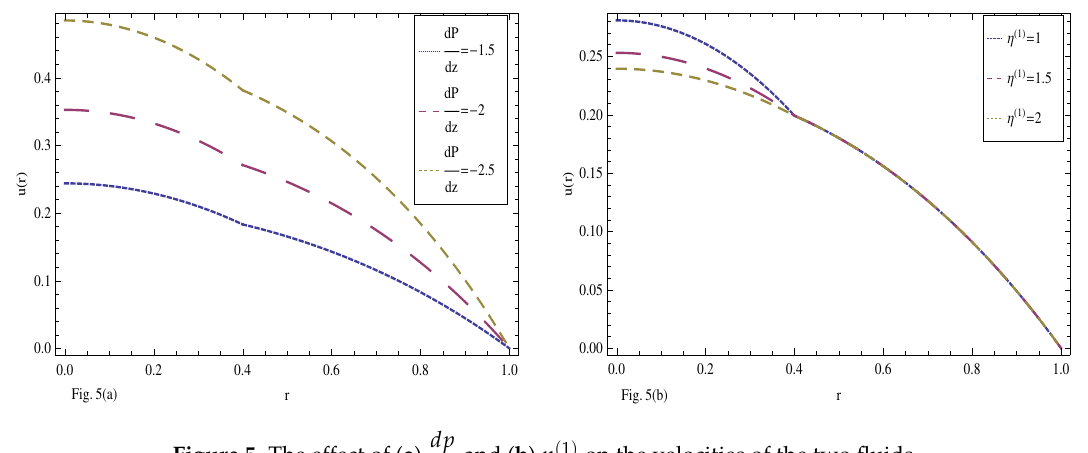
Figure 5. The effect of ( a )